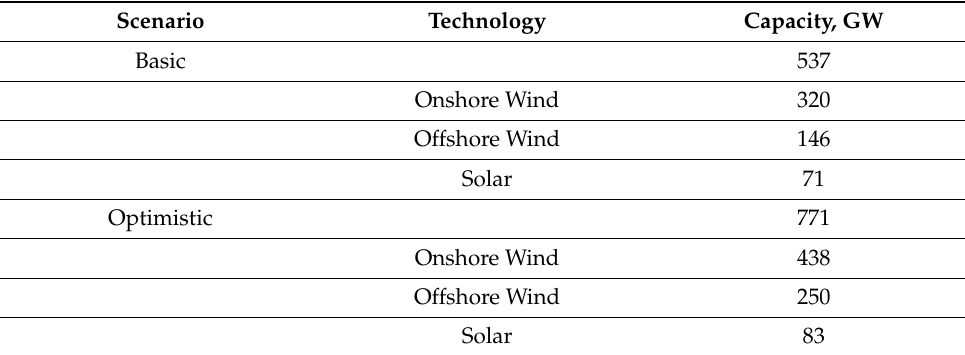
Table 2. Energy potential of RES in Ukraine [5]. Scenario